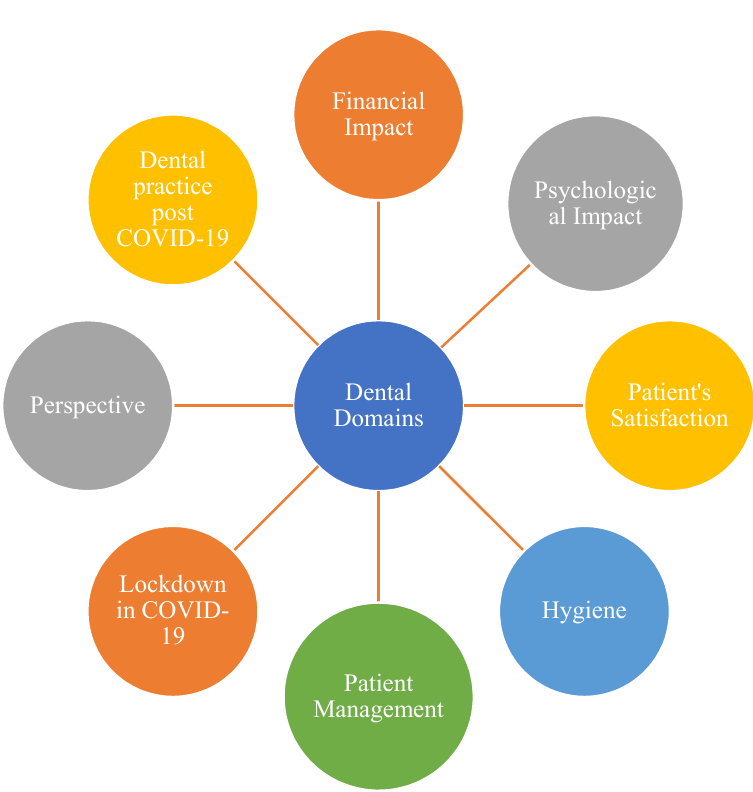
Figure 1. Diagram of dental domains.